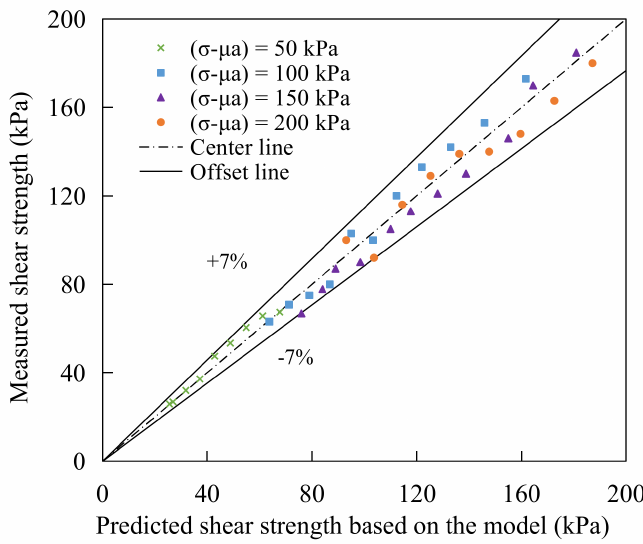
Figure 17. The comparison between the predicted and measured shear strength.